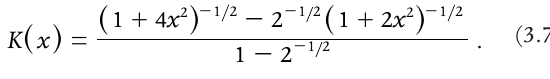
and the second 1 = r